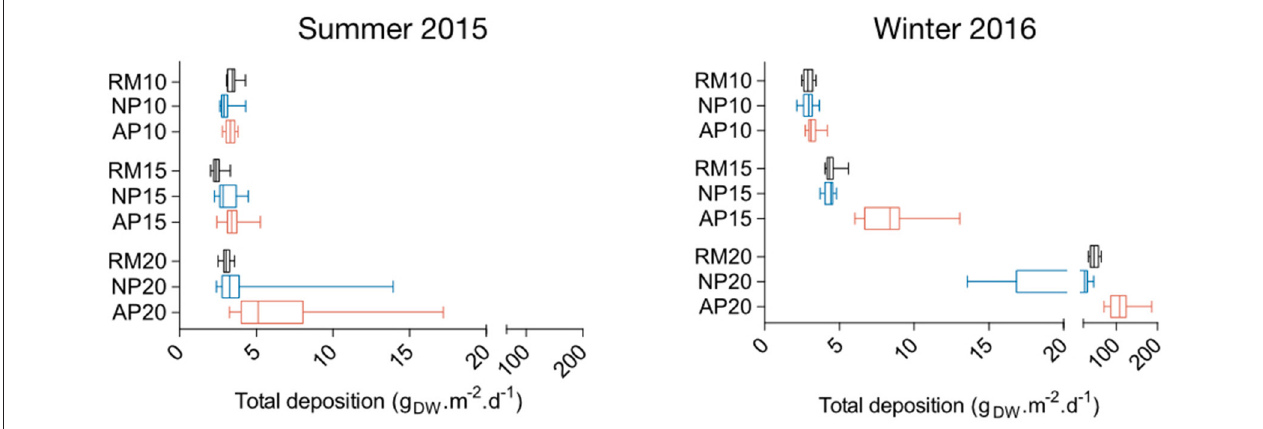
FIGURE 8 | Boxplots of total particle deposition within natural (NP, blue) and anchoring patches (AP, red) and in continuous reference meadows (RM, black) at 10, 15, and 20m depth in summer 2015 and winter 2016. Double bars represent minimum and maximum